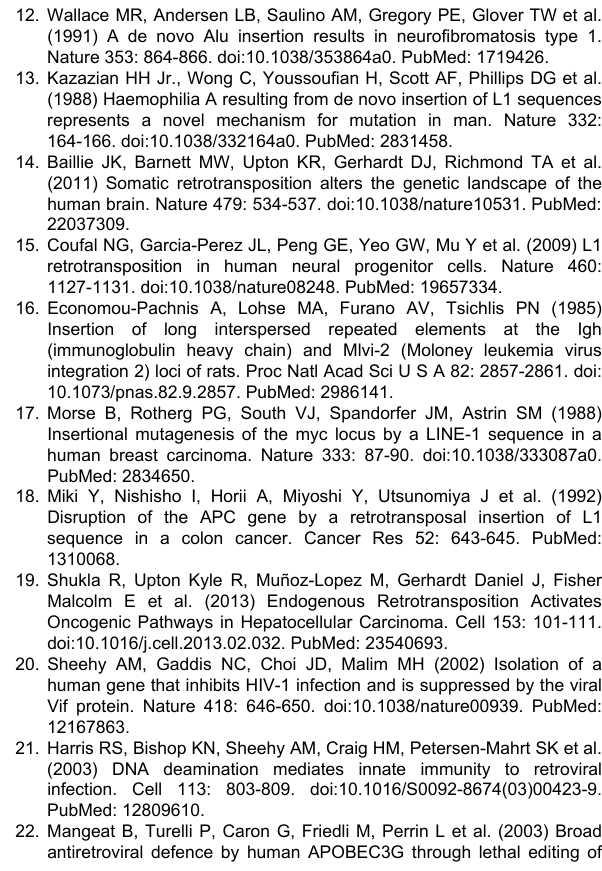
Figure S1. Inhibitory effect of hA3G deletion mutants on HIV-1 infection was evaluated by cotransfecting 293T cells with hA3G and VSV-G plasmids, together with a luciferase- based Vif (- ) Env (-) HIV-1 construct, as described by Iwabu et al . (J. Biol. Chem., 285: 35350-8, 2010) . After 48 h, each viral supernatant was harvested. Normalized supernatants were incubated with 293T cells for additional 48 h. Cells were then lysed and subjected to luciferase assay. The data shown are the mean ± SD of triplicate experiments. RLU: relative light units. (TIF) Figure S2. Cellular RNA contributes to the stabilization of hA3G’s oligomer. HA-tagged hA3G-WT in the immunoprecipitate as described in Figure 4, with or without RNase A treatment. (TIF) Figure S3. hA3G mutants with individual amino acid substitutions. (A) Oligomerization assay was performed by IP- Western blot analysis, as described in Figure 4; upper, IP; lower, cell lysates. (B) An Alu retrotransposition assay was